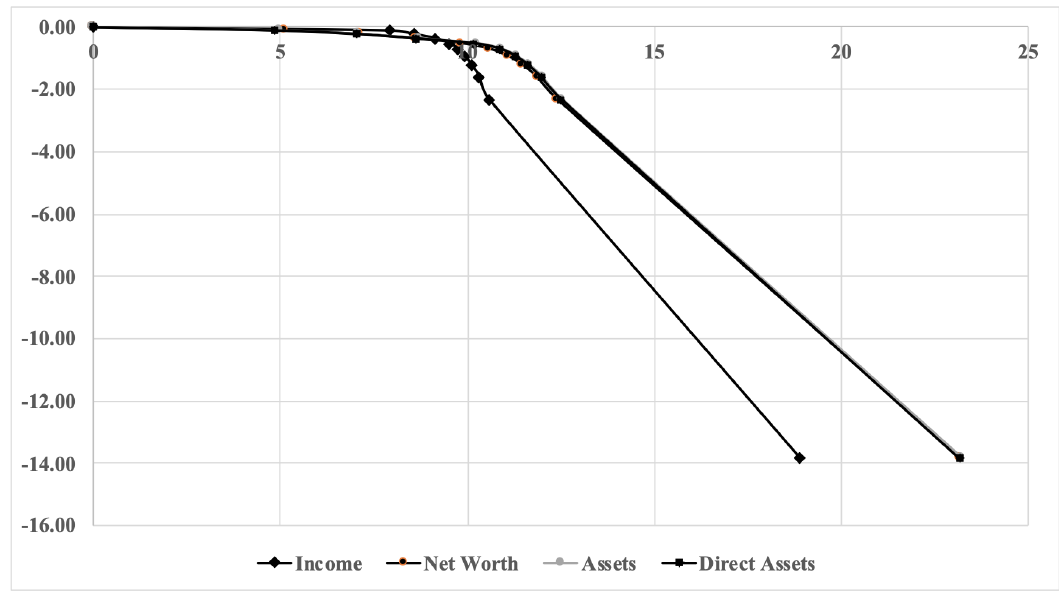
Figure 2. Distributions: ln − ln of income, wealth and